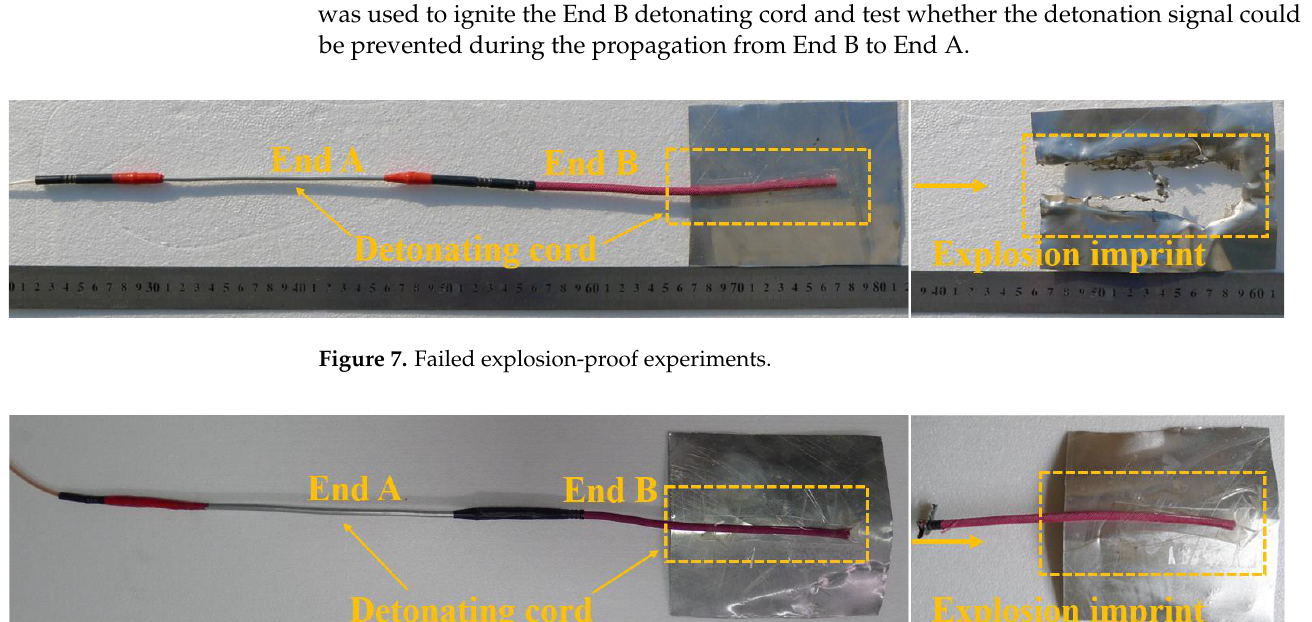
Figure 6. Structure diagram of the explosion-proof experiment, 1 — detonator, 2 — detonating cord of end B, 3 — explosive diode, 4 — detonating cord of end A, 5 — the thickness of 0.2 mm iron-plate.